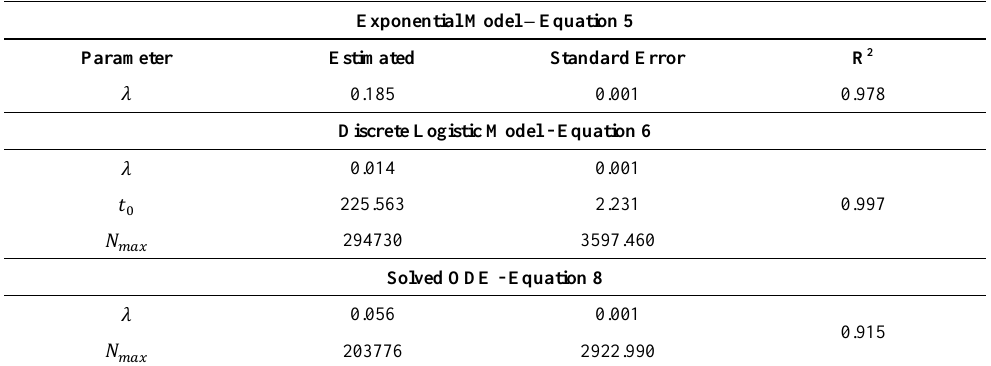
Table 1. Estimated parameters using the different models of the present work. The 𝝀 represents the estimated (exponential or logistic) growth rate, 𝑵 is the maximum number of infected people, and 𝒕 𝒎𝒂𝒙